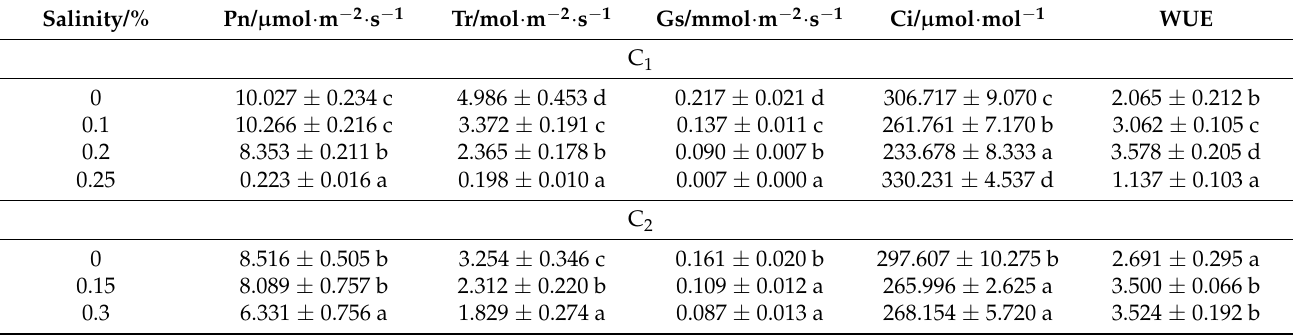
Table 2. Photosynthetic parameters of mulberry seedlings under salt stress. Means with different letters indicate significant differences below